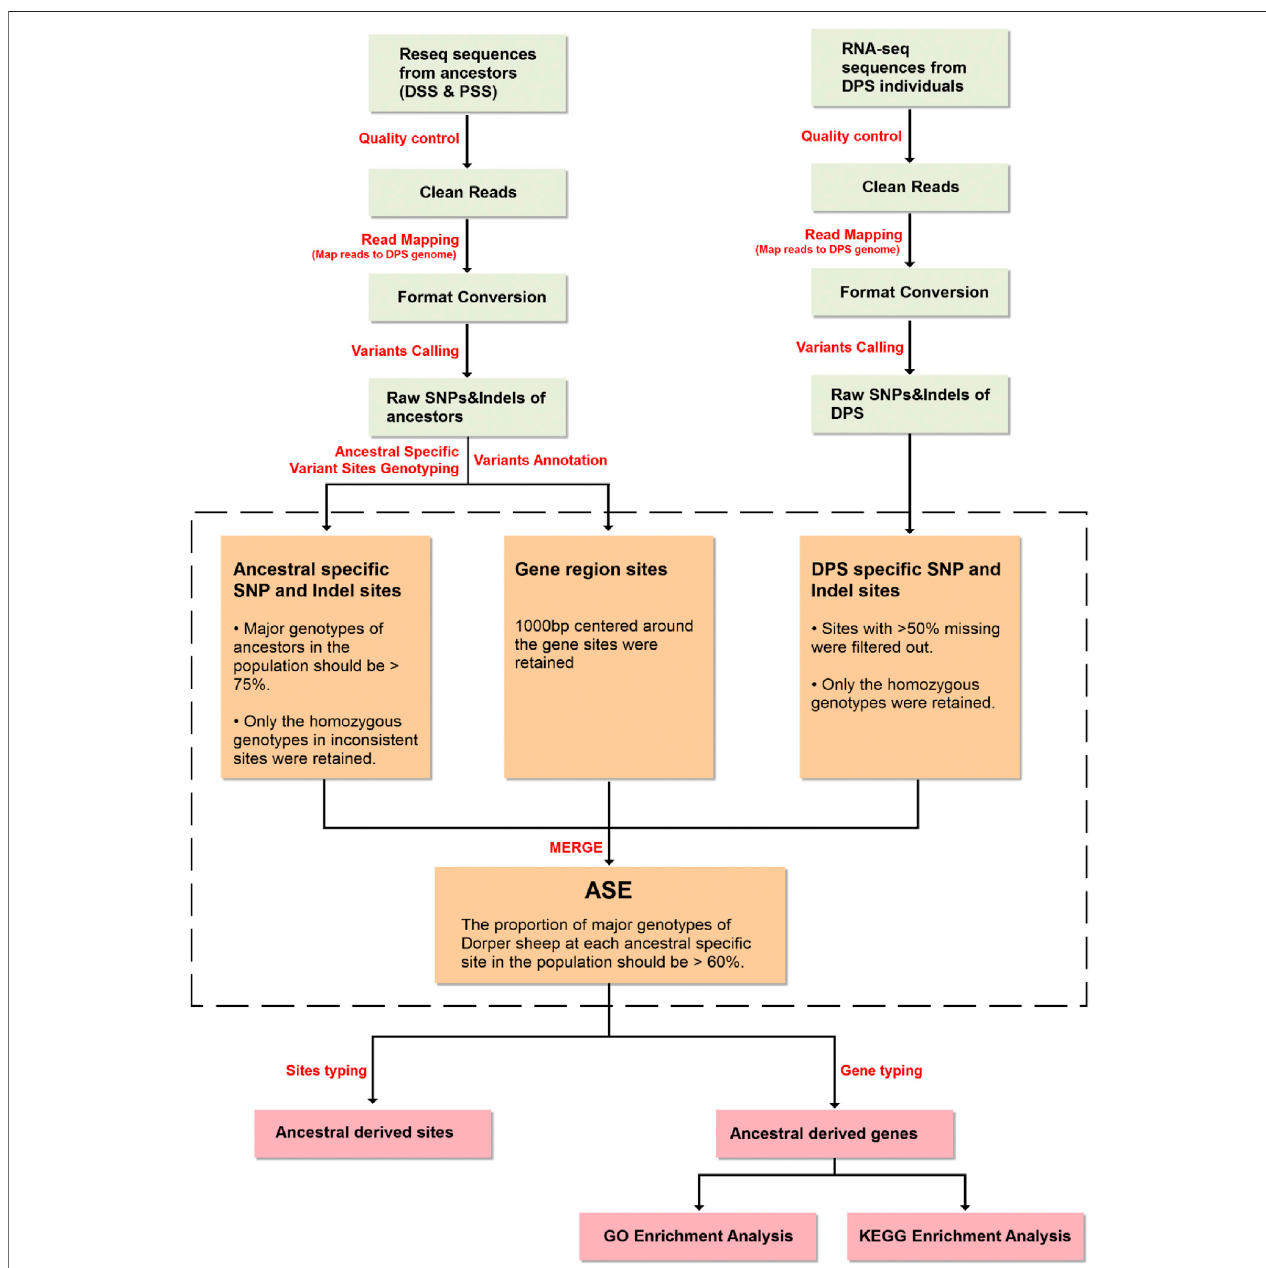
FIGURE 3 | Bioinformatics pipeline for allelic genes expression estimation.